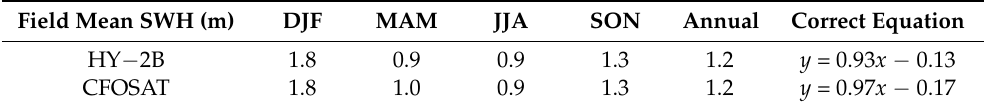
Table 1. Seasonal field mean SWH and correct equations.